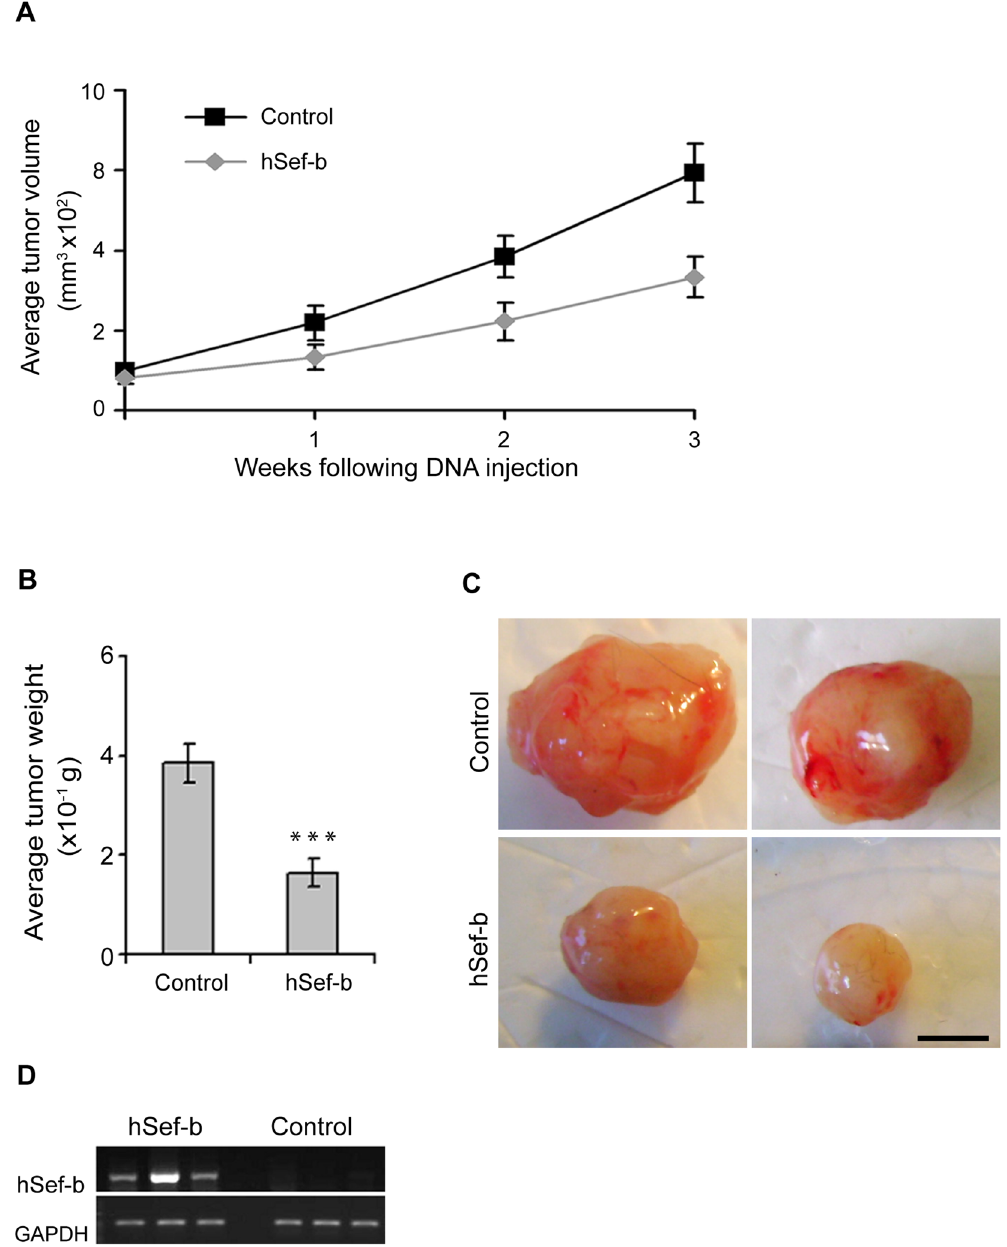
Figure 3. hSef-b suppresses tumor growth in vivo . ( A ) Average volume of tumors transfected with control empty vector (N = 14) or with hSef-b construct (N = 12) by TUS. Tumor volume was measured at weekly intervals during the 3 rounds of DNA injections. ( B ) Average tumor weight at the end of the experiments ( *** p ≤ 0.0001). ( C ) Images of representative tumors. Bar: 2.5 mm. (D ) RT-PCR analysis for the detection of hSef-b transcript in total RNA extracted from the resected tumors. Amplification was carried out with hSef-b specific